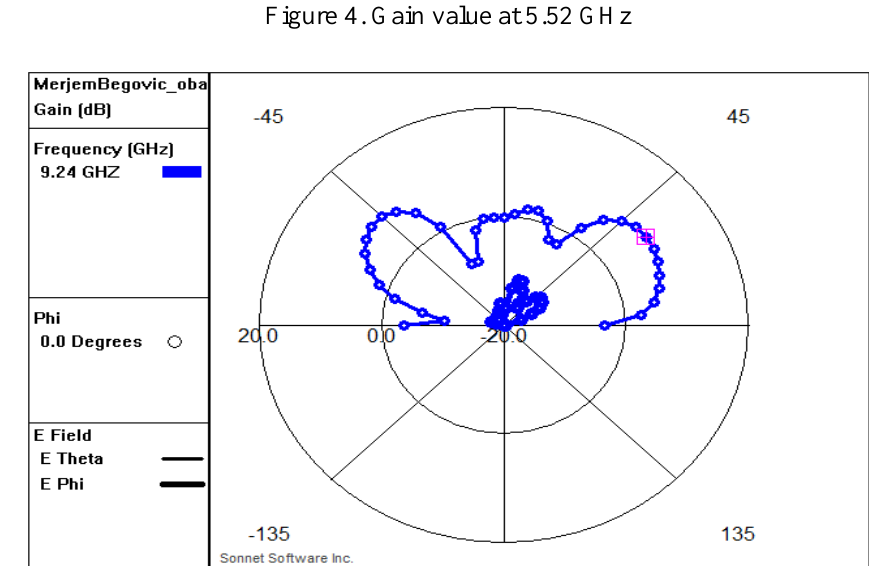
Figure 5. Gain value at 9.24